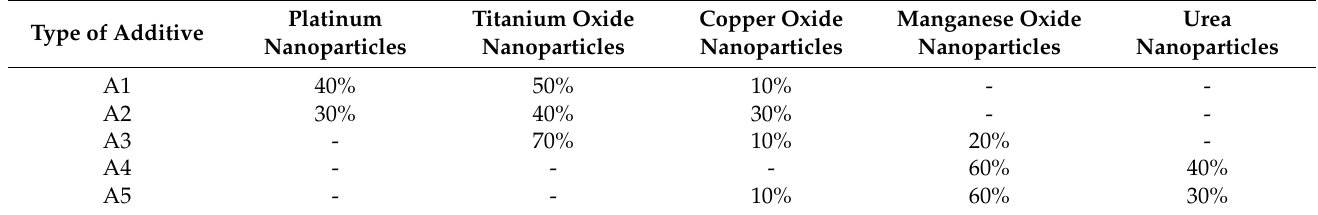
Table 1. Mass fraction of individual active substances in the produced catalytic additives.